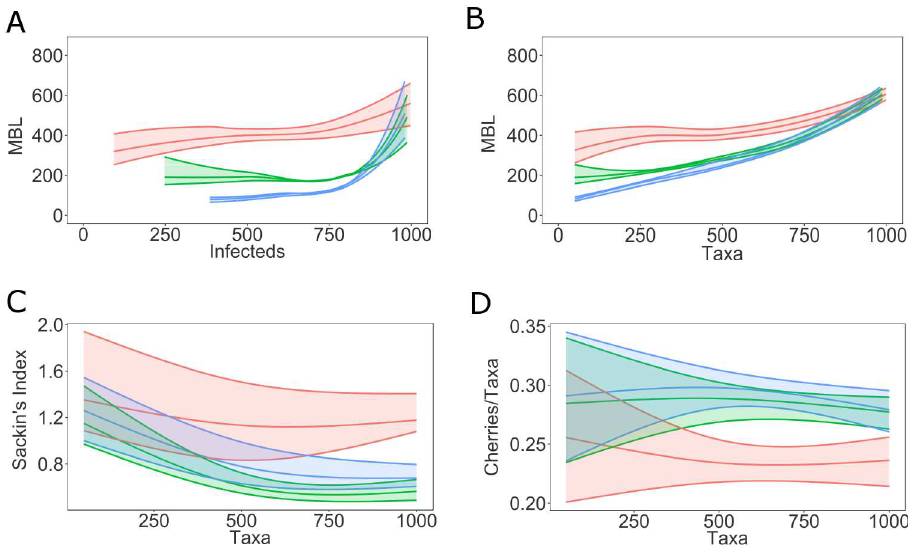
Fig 6. Distance based and topological tree statistics on virus genealogies as epidemic progresses on a network of size 1000. Mean branchlength (MBL) as function of the numberof infected individuals(A) and as function of the number of taxa (sampledinfected individuals) (B) for simulatedoutbreaks on networksof size 1000 as epidemics progress. Note that there is a time intervalbetweeninfectionsand diagnoses(which correspond to removal/sampling times). Sackin’s index (C) and numberof cherries per taxa (D) as function of the numberof taxa in networks of size 1000. The envelopes represent95% confidenceintervals aroundthe medians.The curves are obtained using local regression (LOESS). WS ( red ), ER ( green ), BA ( blue